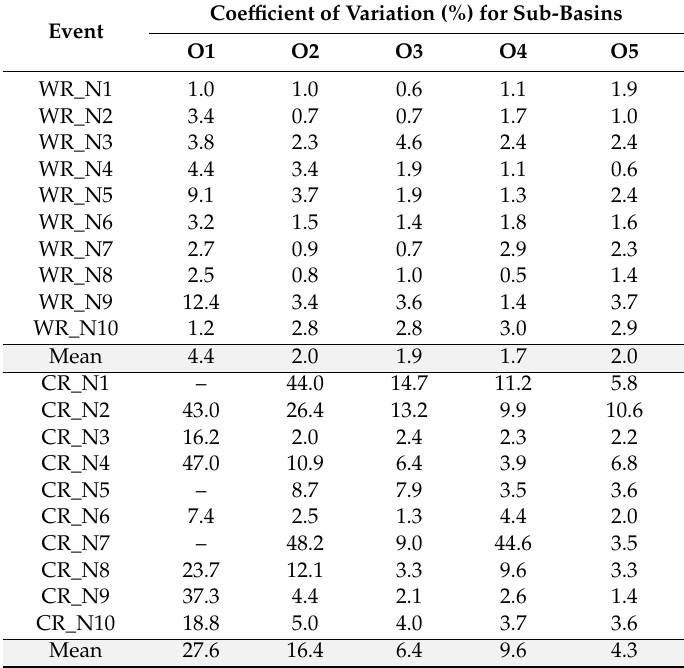
Figure 11. Time series profile of the simulated discharge at the outlet of sub-basin O2 of the Tsurumi River Basin for the events of ( a ) 2–3 May 2012 (WR_N1), and ( b ) 5–6 August 2012 (CR_N1). Table 6. Coe ffi cient of variation of the simulated discharge obtained from di ff erent rescaled rainfall data in the model for the outlets of sub-basins in the Tsurumi River